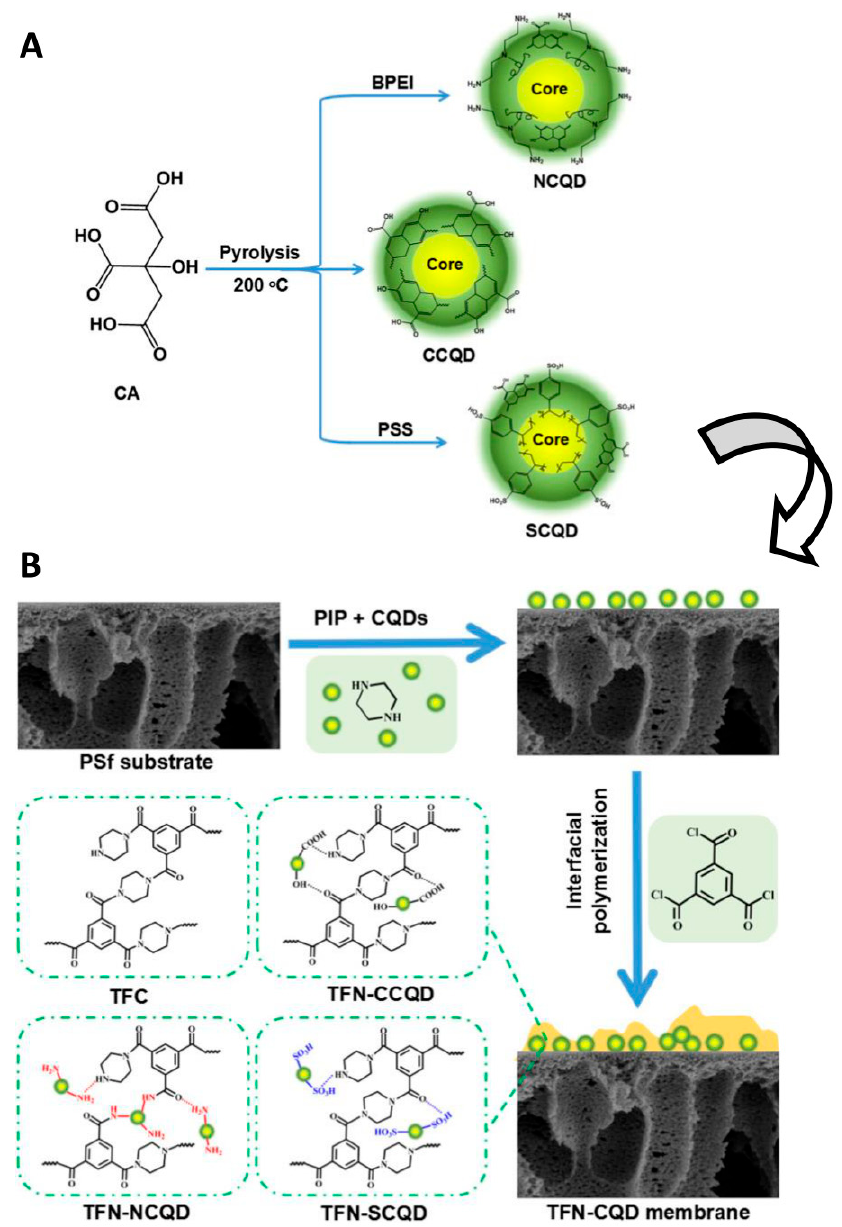
Figure 5. ( A ) Representation of the preparation process of three CDs. ( B ) Schematic representation for the production of various TFN-CD membranes through interfacial polymerization. Reprinted with permission from [82]. Copyright (2018) Elsevier.